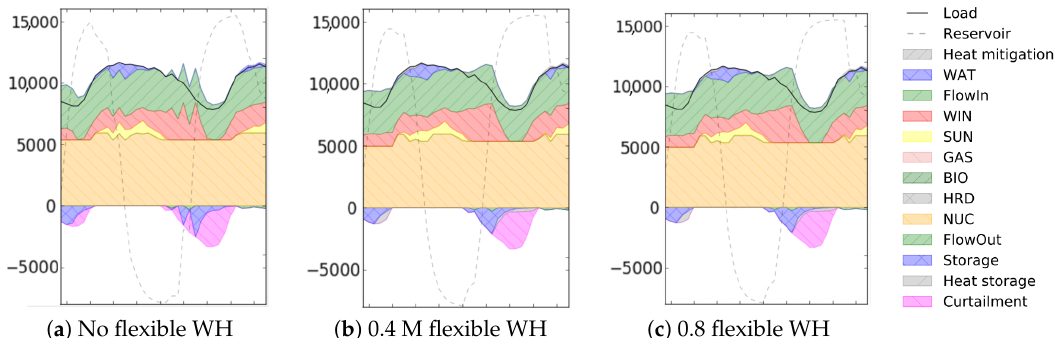
Figure 8. Curtailment reduction for different numbers of flexible water heaters (R2, nuclear power (non-flexible), September 16) (MW).